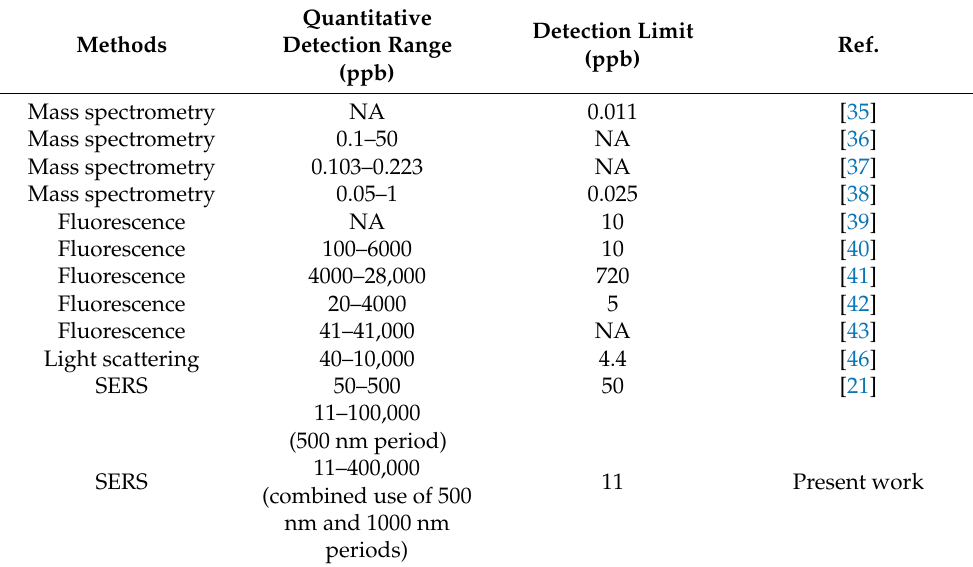
Table 1. Performance of each method for the detection of trace